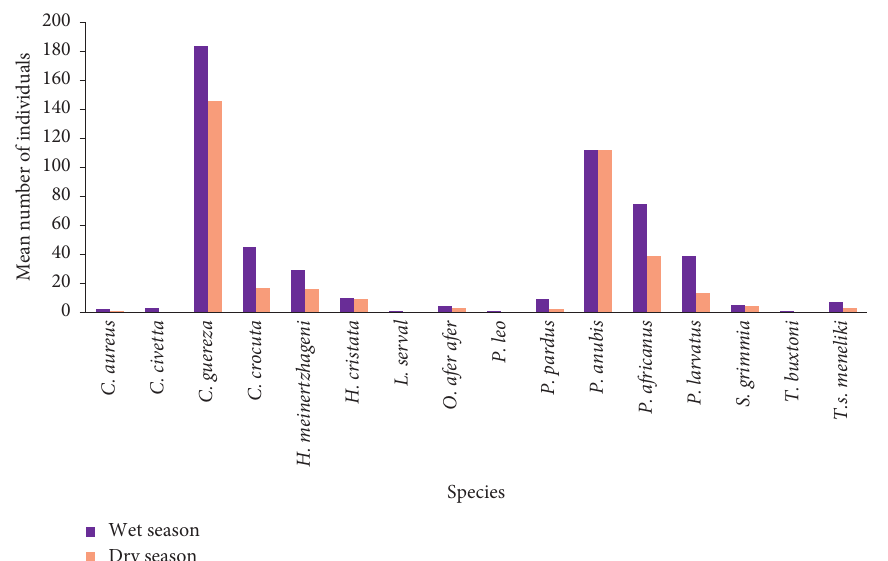
Figure 6: Seasonal variation in species composition and mean abundance of large wild mammals in Nensebo forest, Southern Ethiopia.